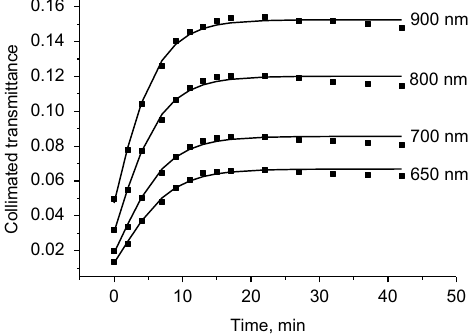
Fig. 3. The experimental (dots) and calculated (lines) time dependences of collimated transmittance of the myocardium sample placed in the 58%-glycerol solution. Table 2. The di®usion and permeation coe±cients of glucose and glycerol in myocardium. Solution Thickness (mm) Di®usion coe±cient (cm 2 /s) Permeation coe±cient (cm/s) a 40%-glucose solution 0.66 (cid:2) 0.13